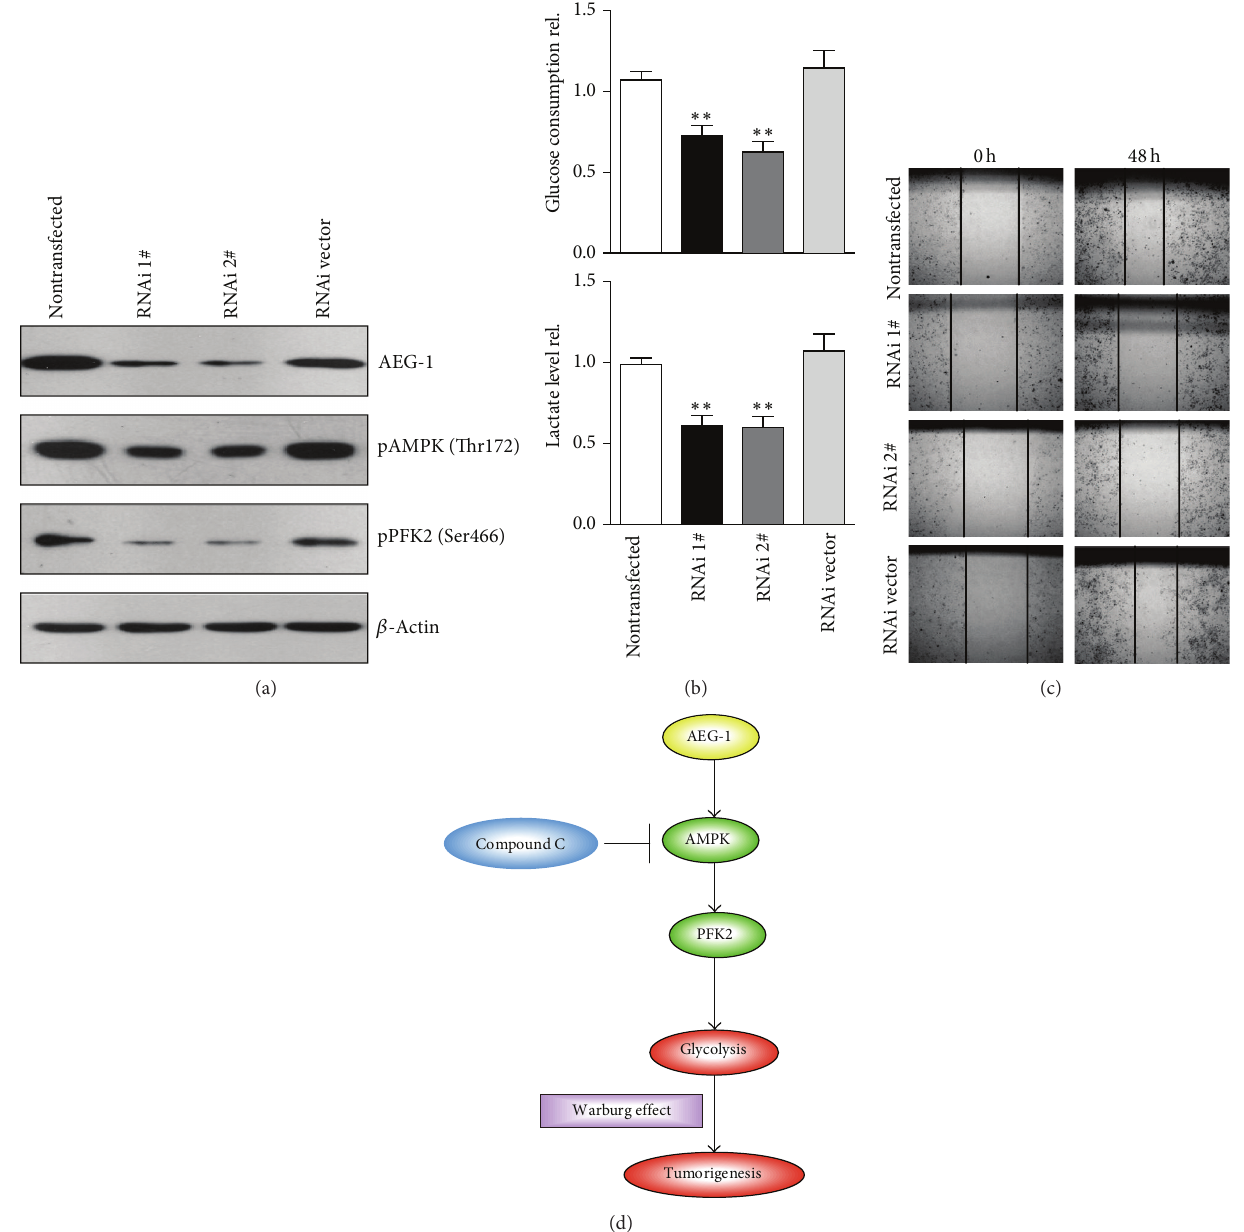
Figure 4: Downregulation of AEG-1 expression reverses AEG-1-mediated increasing of glycolysis in HCT116 tumor cells. (a) Western blots showing that decreasing AEG-1 protein levels by RNAi reduced AMPK phosphorylation and PFK2 phosphorylation in HCT116 tumor cells. (b)BiochemicalassaysshowingthatdecreasingAEG-1proteinlevelsbyRNAireducedglucoseconsumptionandlactateproductioninHCT116 cells. Results were averages of four independent experiments. Data represent mean ± SEM. ∗∗ 𝑃 < 0.01 . (c) Images showing that the decreased AEG-1 protein levels may inhibit cell migrations in HCT116 cells. (d) Schematic representation highlighting the molecular link between AEG- 1 and glycolysis. AEG-1 may increase the activity of AMPK by Thr172 phosphorylation. The activated AMPK then raises PFK2 activity and promotes glycolysis, as is called Warburg